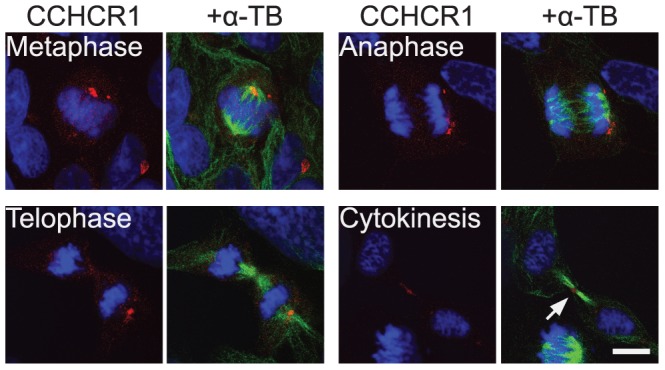
CCHCR1 protein is expressed throughout the cell cycle but the localization is dynamic.Ds-Red-tagged CCHCR1 (red) is stably expressed and the cells are stained with α-tubulin (α-TB, green) antibodies for the detection of different points of the cell cycle (metaphase, anaphase, telophase and cytokinesis). Near the end of cytokinesis CCHCR1 is also detectable at the midbody region (arrow) connecting the dividing cells. DAPI stained nuclei are shown in blue. Scale bar 10 µm.